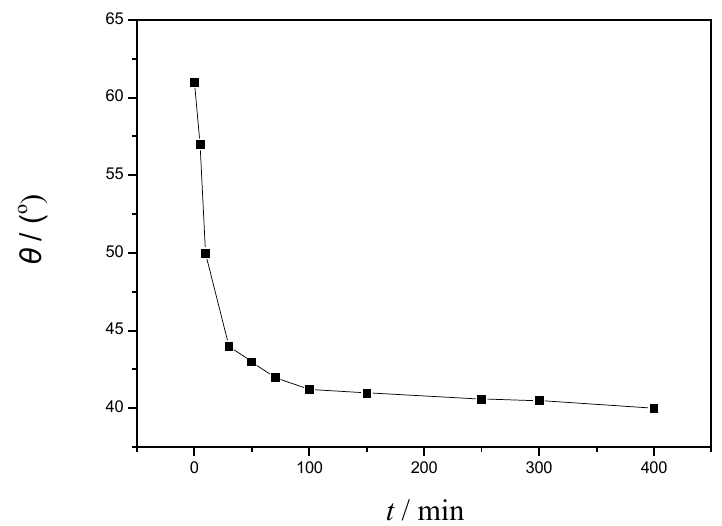
Figure 2. Plot of advancing contact angle of ME/Au SAMs vs. assembling